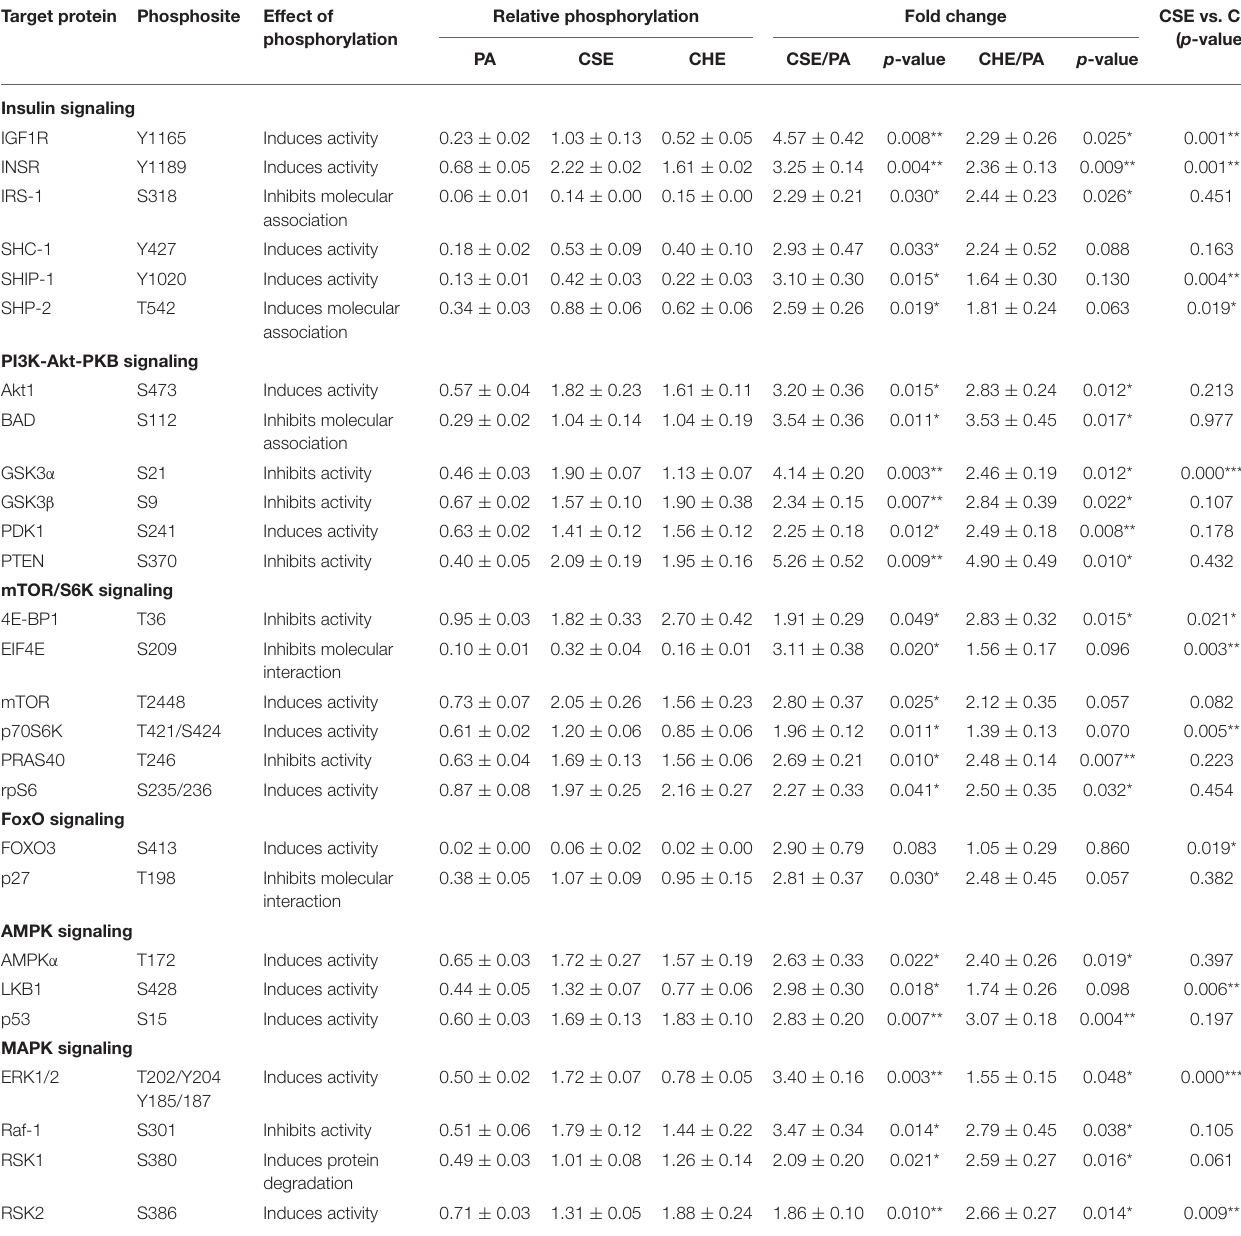
TABLE 1 | Effect of coffee by-products’ aqueous extracts on the phosphorylation of proteins related to different metabolic pathways in hepatocytes. Target protein Phosphosite Effect of